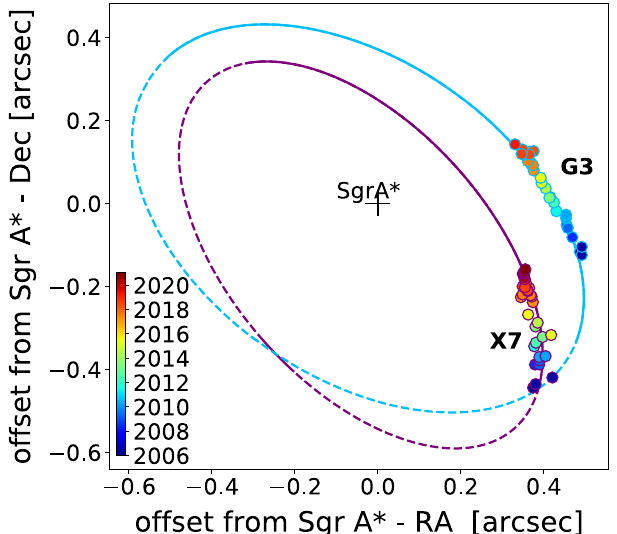
Figure 9. Orbit comparison of X7 and G3. X7 ( purple curve ) and G3 ( blue curve ) move in similar ways on the plane of the sky and have similar orbits. We fi nd that X7 ʼ s period, inclination, angle of ascending node, and argument of the periapse ( respectively 165 yr, 58 ° , 43 ° , and − 76 ° ) are similar to those obtained in Ciurlo et al. ( 2020 ) for G3 ( respectively 156 yr, 52 ° , 55 ° , and − 99 deg ) . The eccentricities are modest for X7 ( 0.34 ) and low for G3 ( 0.11 ) . Additionally, both objects are in the same phase of the orbits and are both blueshifted ( with a difference in radial velocity of 100 km s − 1 in 2006 )